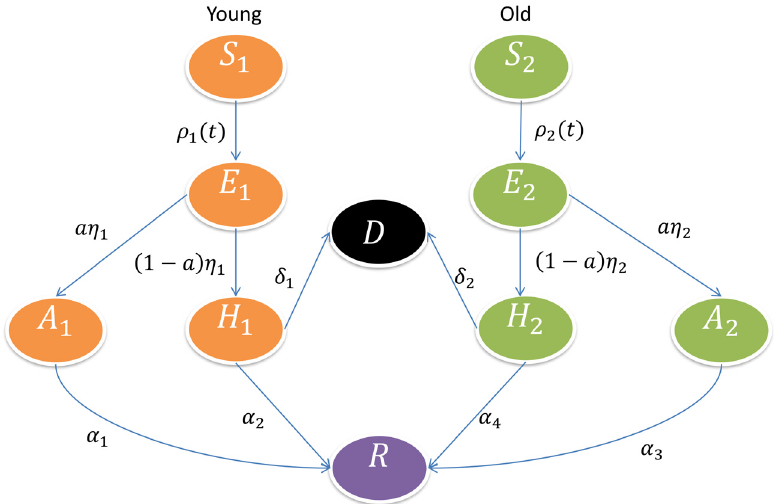
Fig 1. With ρ 1 ( t ) = β S 1 [ ϕ ( A 1 + � A 2 ) + ( H 1 + H 2 )] and ρ 2 ( t ) = β S 2 [ ϕ ( A 1 + � A 2 ) + ( H 1 + H 2 )], disease related stages are shown in orange color for young population and in light green for the old population. Deceased and recovered population include both age groups and are shown in black and purple,